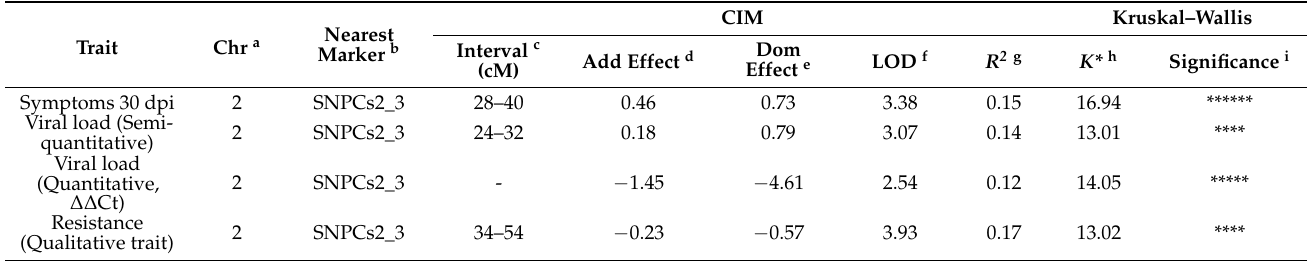
Table 4. Quantitative trait loci (QTLs) identified in the F 2 segregating population using composite interval mapping (CIM) and Kruskal–Wallis tests.